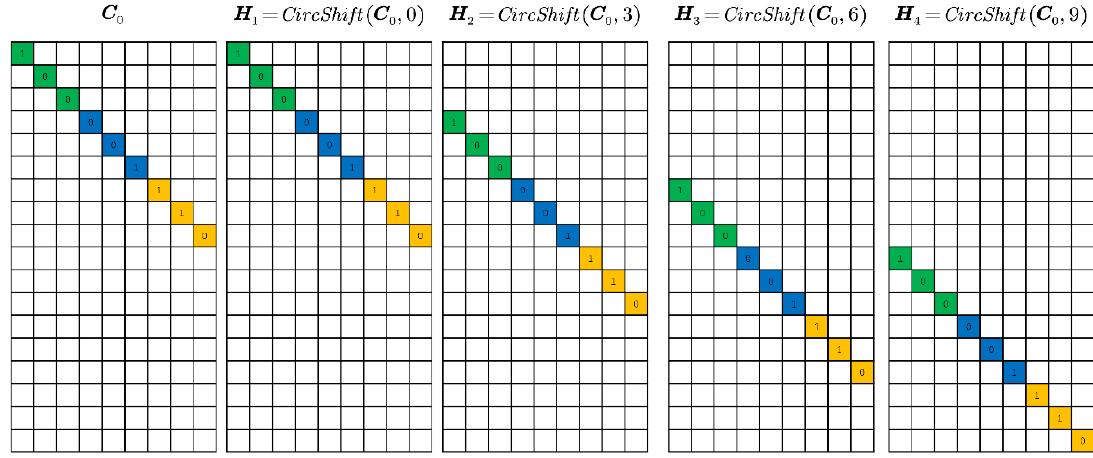
Figure 6. Example of the matrix . Different colours represent different rows of